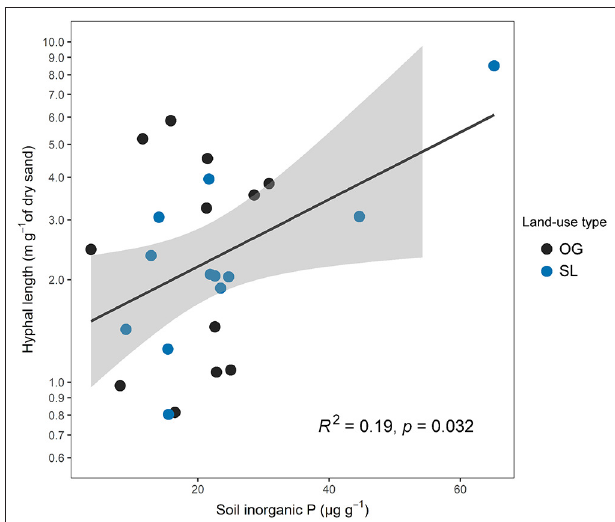
FIGURE 6 | Relationship between mycelial production (hyphal length) and soil inorganic P concentrations across old-growth (OG) and selectively logged (SL) lowland dipterocarp rainforest in Sabah, Borneo. Hyphal length values are shown on a log scale corresponding to statistical tests. This relationship was found to be non-significant when the data point with high values in both parameters (top-right) was excluded from analysis ( F = 0.83, R 2 = 0.04, p =